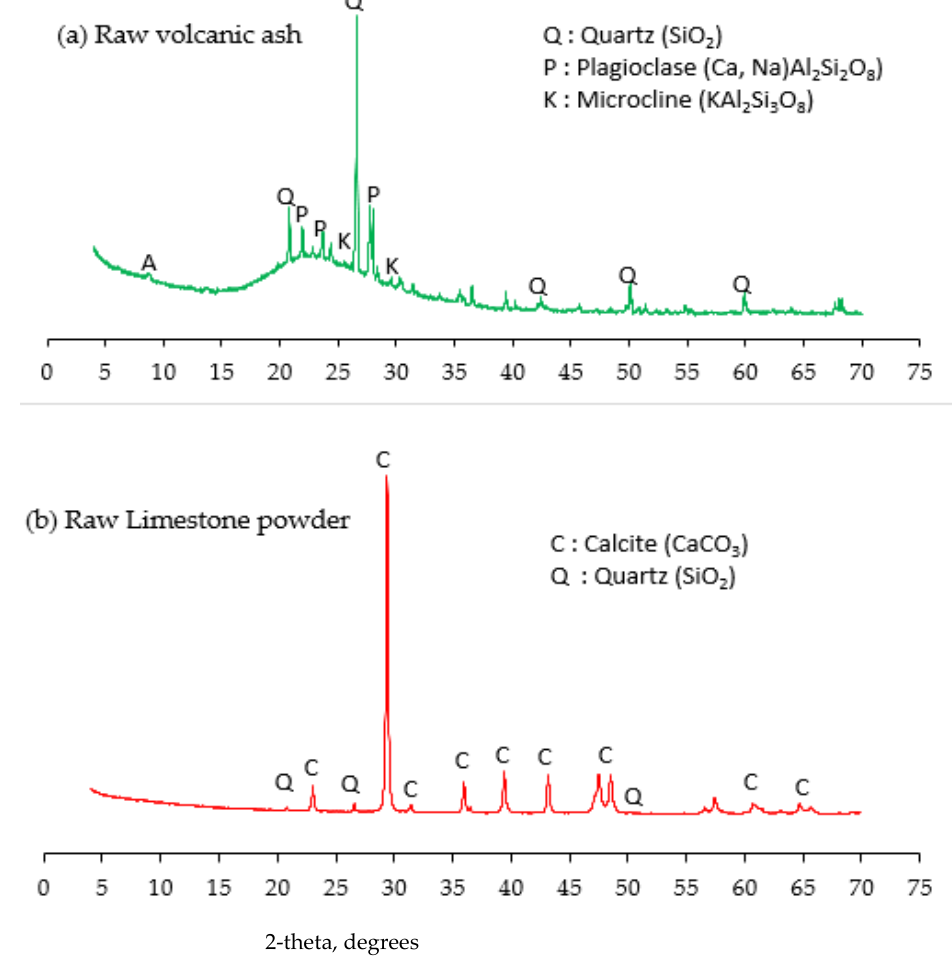
2-theta, degrees. Figure 3. XRD pattern: ( a ) Raw volcanic ash ( b ) Raw limestone powder. Figure 3. XRD pattern: ( a ) Raw volcanic ash ( b ) Raw limestone Figure 3. XRD pattern: ( a ) Raw volcanic ash ( b ) Raw limestone powder.